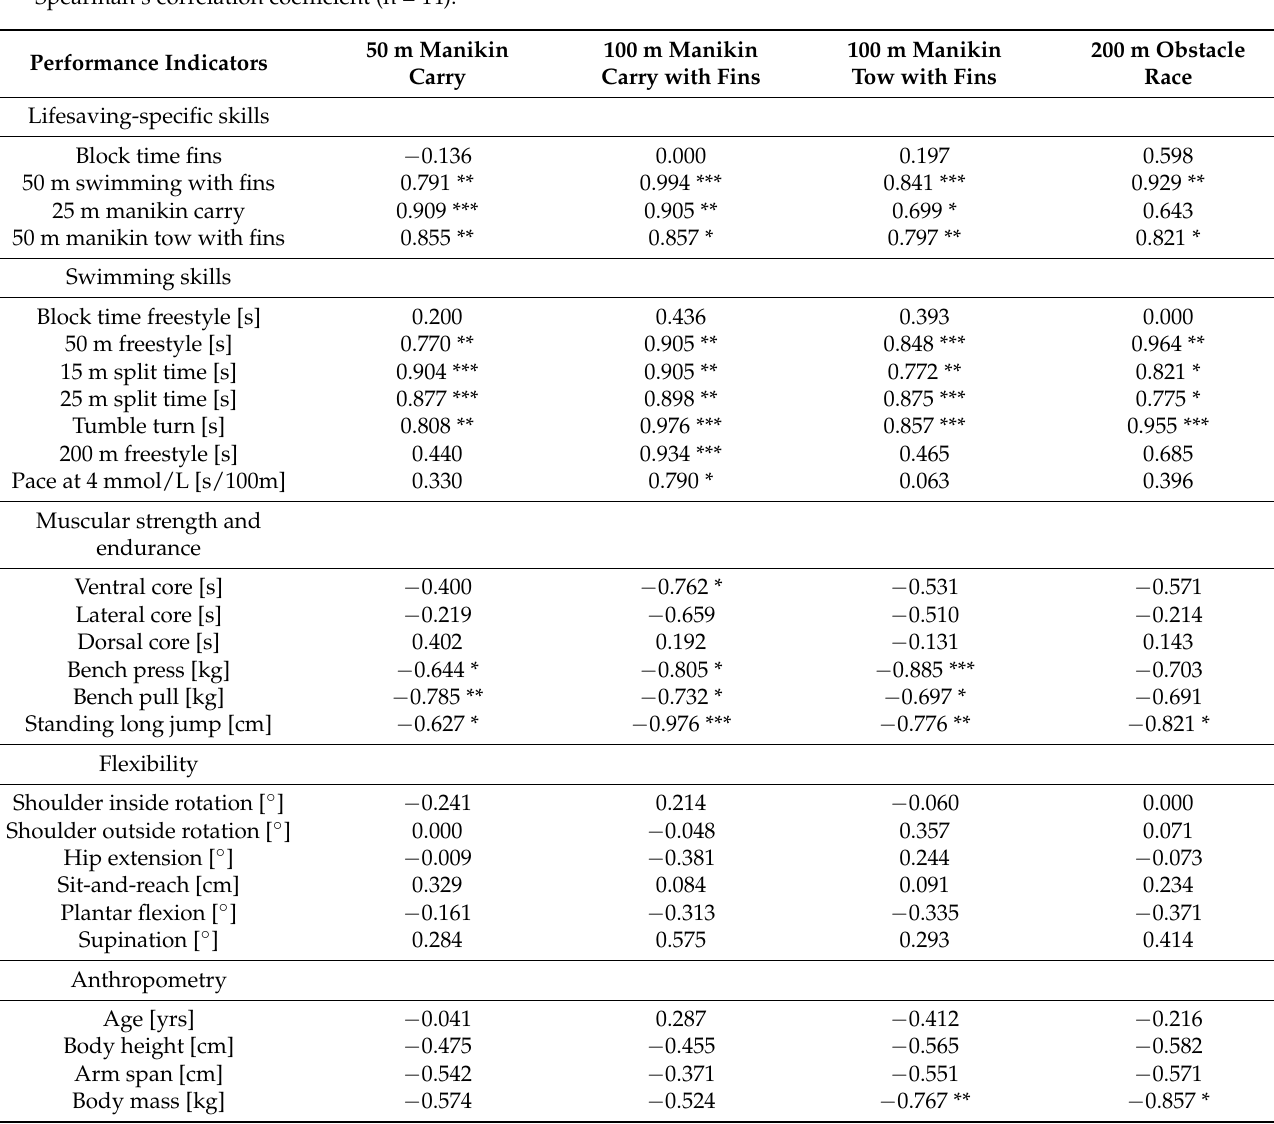
Table 2. Performance indicators correlated with race times from pool-based disciplines of competitive lifesaving using Spearman’s correlation coefficient (n =